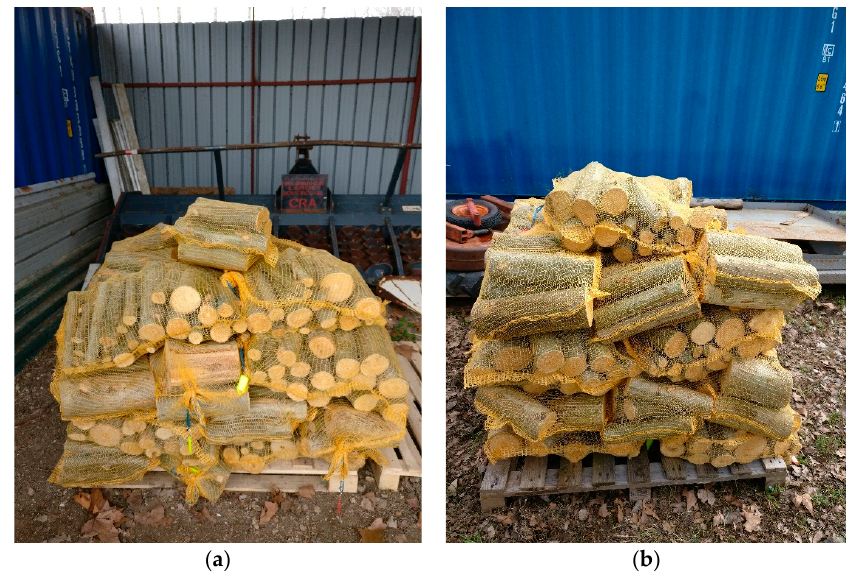
Figure 4. Open shed ( a —OSF) and outdoor ( b —ODF) storage of firewood logs in mesh bags.